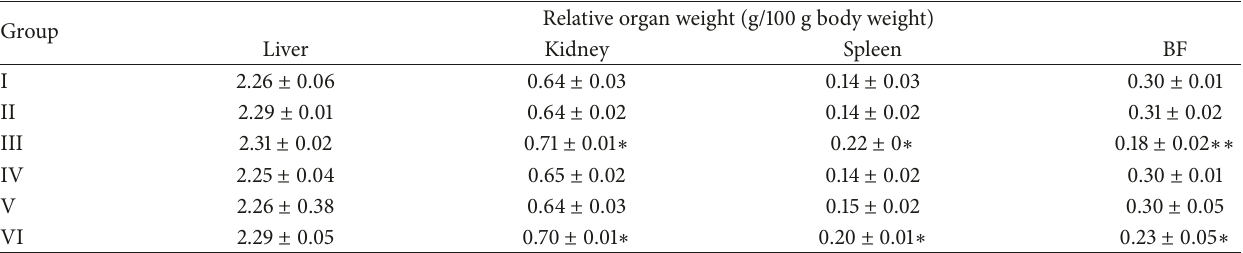
Table 5: Effects of 5% SAP on the relative organ weight of broiler chickens fed a diet naturally contaminated with AF at 21 days of age.